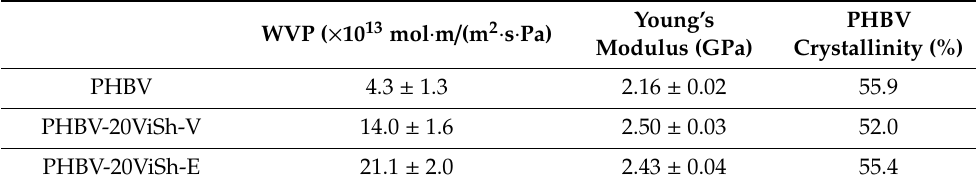
Table 2. Properties of PHBV-based composites with ViSh fillers (from [18]).